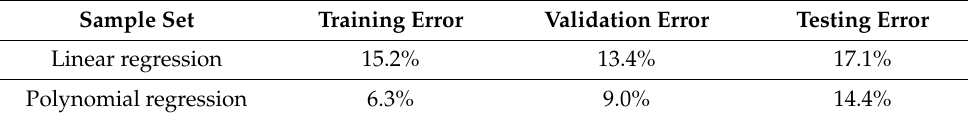
Table 9. Error of the linear and polynomial regression models.